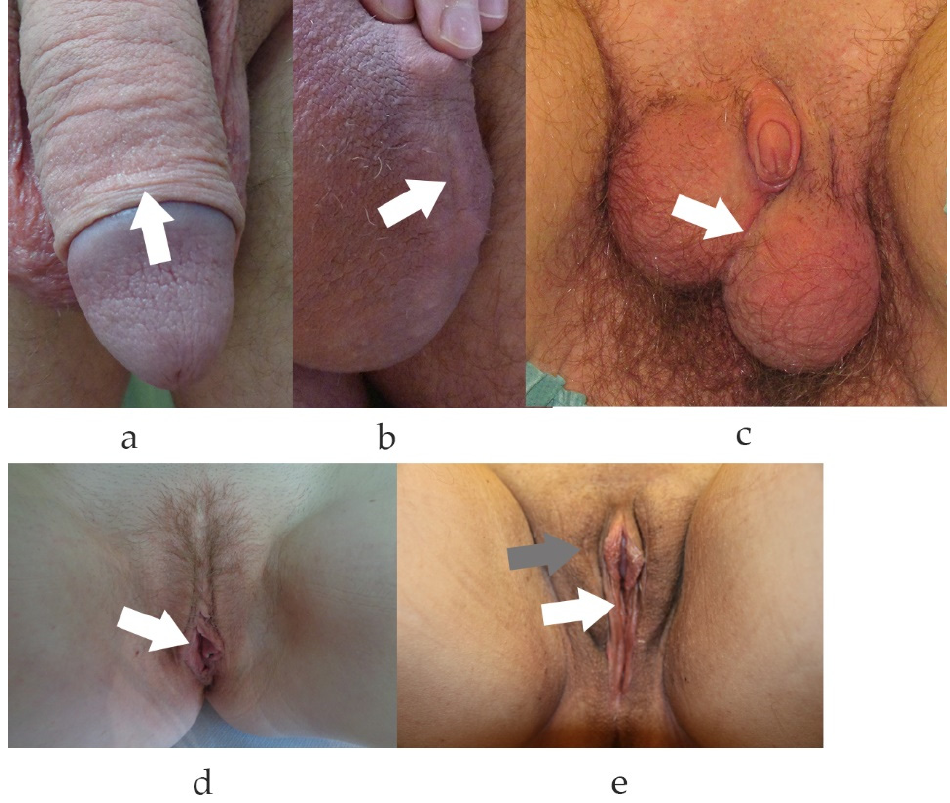
Figure 1. Genital scars of male, female and gender reassigned genitalia. ( a ). Typical scar after circumcision. Note, the scar is only visible due to different pigmentation of the inner and outer part of the penile foreskin. ( b ). Scrotal scar after abscess excision. Visible scar after prolonged inflammatory phase. ( c ). Scarring after female-to-male reassignment surgery with neo-scrotal sac formed from the major labia and metoidioplasty. ( d ). Scarring after surgical reduction plasty of the small labia. ( e ). Genital aspect and scarring after male-to-female reassignment surgery. In ( e ), grey arrow depicts the scar to the great labia (prior scrotal skin), the white arrow to the small labia (prior penile skin). ( a – e ). White arrows depict the scars.